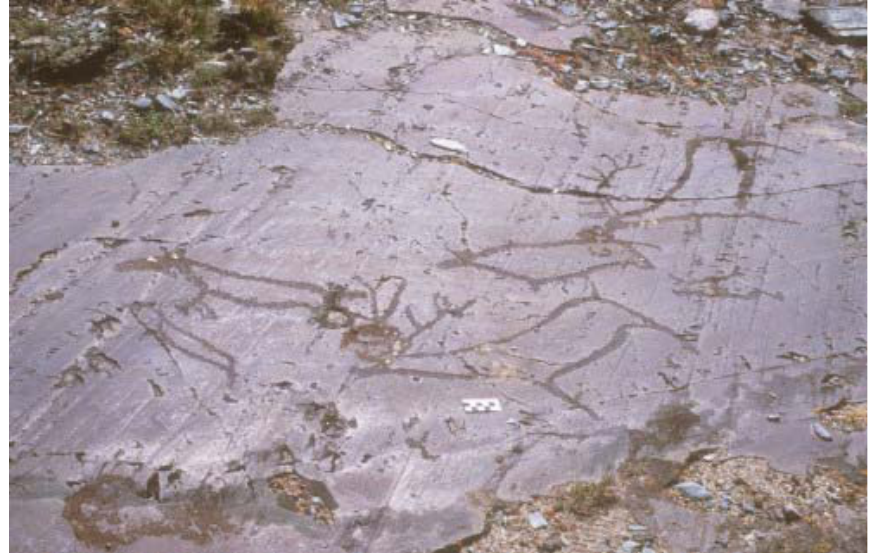
Figure 19. Possible hunting scene, with horses, elk, aurochs and a profile human figure. Pre-Bronze Age. Aral Tolgoi.